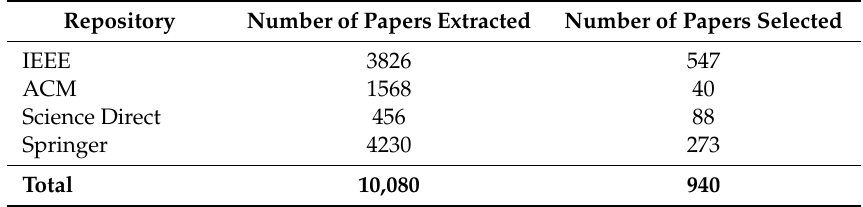
Table 2. Number of papers extracted according to the quality assessment